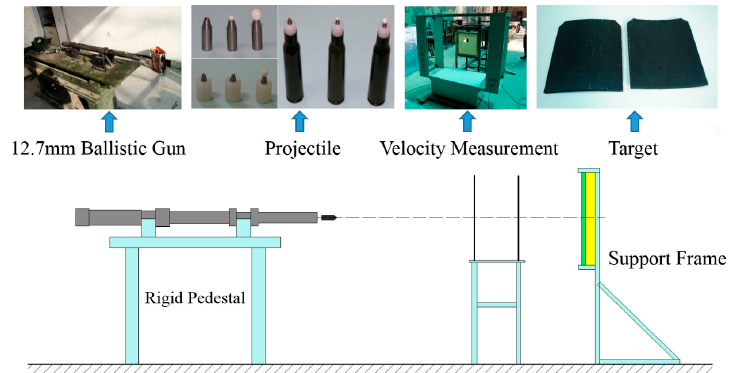
Figure 4. Schematic of the experimental setup.